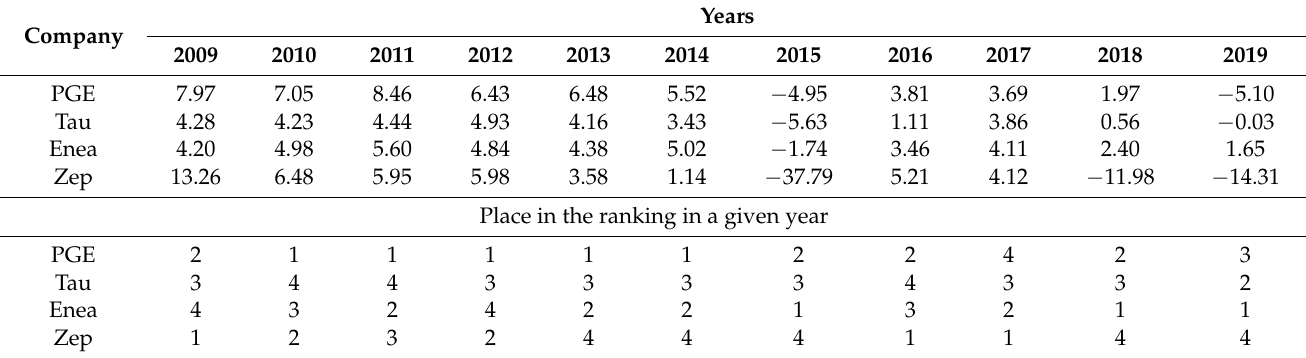
Table A1. ROA (%) ratios and the position of companies in the ranking in the years 2009–2019.